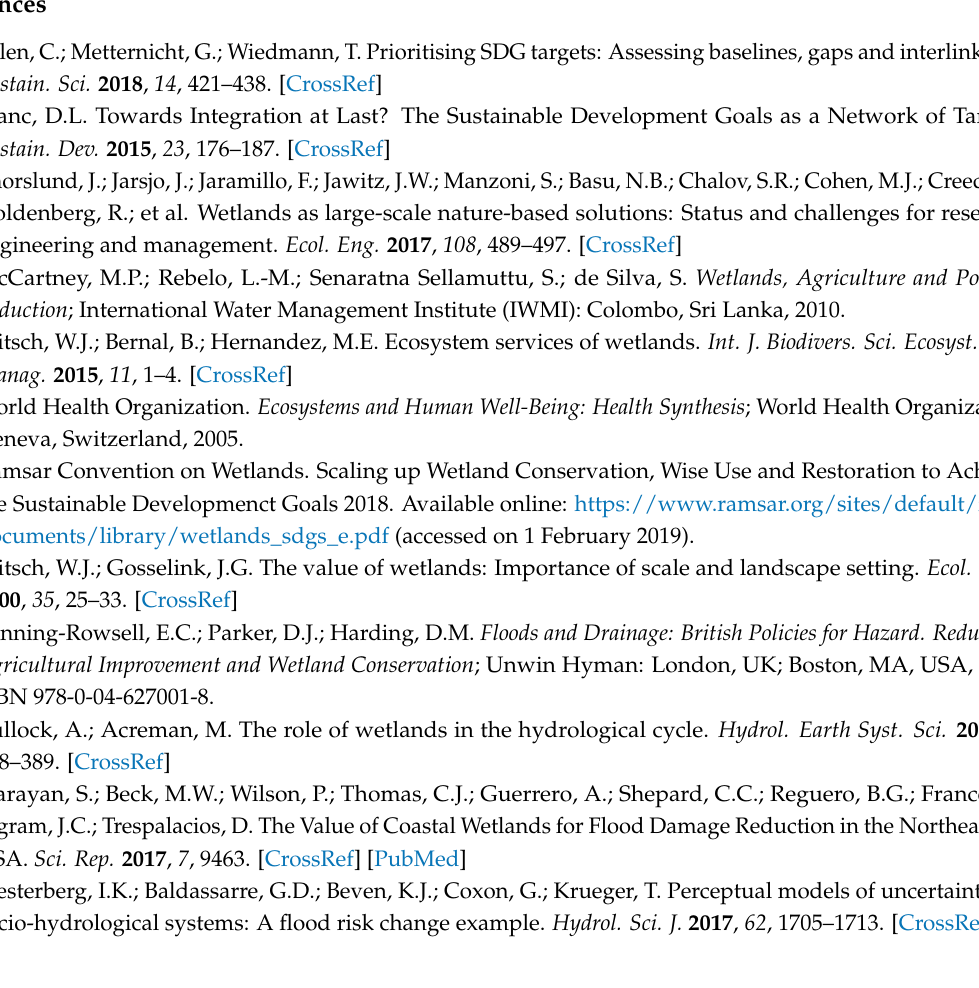
Table S1: Detailed information on the 45 wetlandscapes used in the study, Figure S1: Example of the Questionnaire filled by each wetland